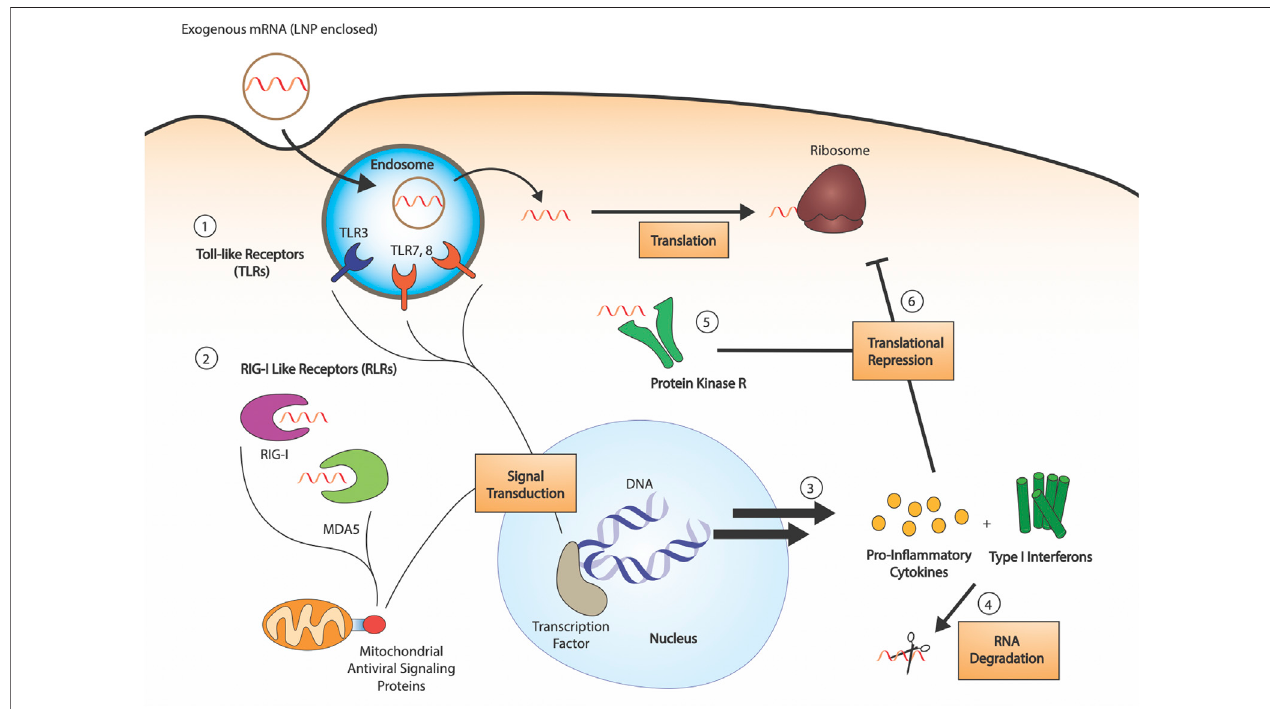
FIGURE 1 | RNA sensing by the innate immune system. 1) RNA sensing Toll-like receptors (TLR3, TLR7, TLR8) are endosomal compartment receptors in sentinel cells, which activate upon late-endosomal acidi fi cation. Exogenous RNA is endocytosed by the cell, and pathogen associated molecular patterns are detected by the TLRs (dsRNAs, uridine-rich ribonucleosides, etc.). 2) RIG-I like receptors (RLRs) are cytosolic receptors present in all cell types. Both RIG-I and MDA5 are 5 ′ - triphosphate dependent sensors, with some af fi nity for both dsRNA and ssRNA. Their activation leads to signal transduction through mitochondrial antiviral signaling proteins. 3) Innate immune detection of exogenous RNA leads to production of pro-in fl ammatory cytokines and type I interferons, which activate RNA degradation 4). 5) Protein kinase R (PKR) is a cytosolic sensor also involved in dsRNA sensing, the activation of which leads to phosphorylation of eukaryotic initiation factor eIF2 α . 6) The combined action of produced cytokines and PKR leads to translational repression.